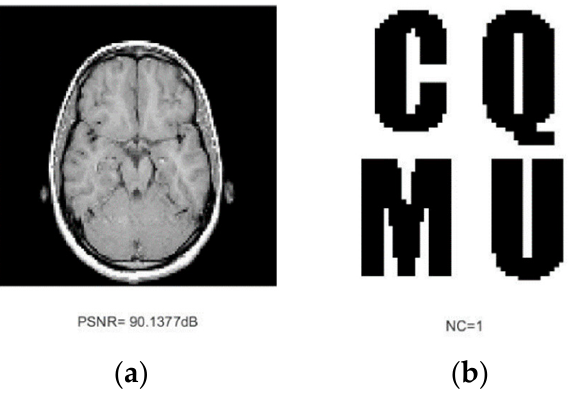
Figure 7. Watermarking image: ( a ) binary watermarking image; ( b ) encrypted watermarking image.